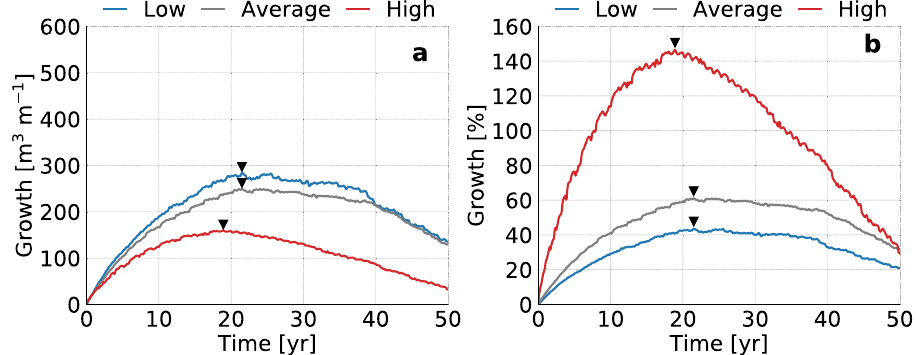
Figure 4. Simulated growth of fresh groundwater for low (blue line), average (dark grey line), and high (red line) estimates of the global hydraulic conductivities, where the black triangles point to the time with the maximum growth of fresh groundwater. The graphs represent the change in volume (left) and percentage (right) with respect to the initial conditions (i.e. equal to equilibrium state without beach nourishment).